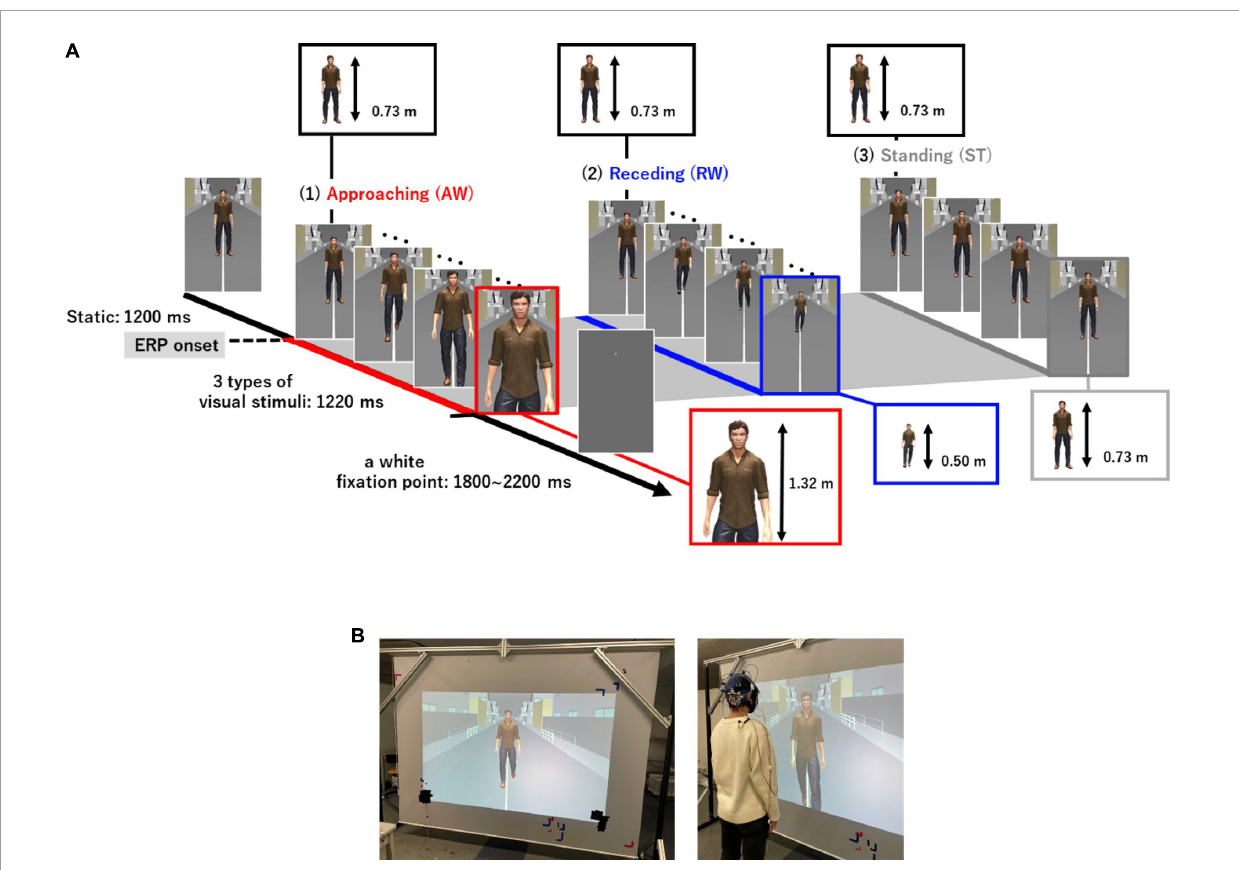
FIGURE1 (A) Three types of visual motion stimuli and the experimental procedure in one trial. The standing image was presented for 1,200 ms, and thereafter, three types of visual stimuli (AW, RW, ST) were presented for 1,220 ms each. After the end of the video for each condition, a white gazing point was displayed for 1,800–2,200 ms. The onset time of each visual stimulus (AW, RW, ST) was used as the ERP onset. The actual height taken up by the virtual avatar in the visual field of the participants changed from 0.73 to 1.42 m in the AW condition and from 0.73 to 0.50 m in the RW condition. In the ST condition, the size of the avatar remained at 0.73 m. Moreover, the maximum avatar size in the AW condition, if it had been projected onto a large enough screen, would have been 2.3 m. (B) Experimental environment. Visual stimuli were cast onto a 2.7 m wide and 1.9 m high screen using a projector with a refresh rate of 60 Hz. The participants observed the visual stimuli in the standing position at 0.6 m away from the screen. AW, approaching walking movement; RW, receding walking movement; ST, standing; ERP, event-related